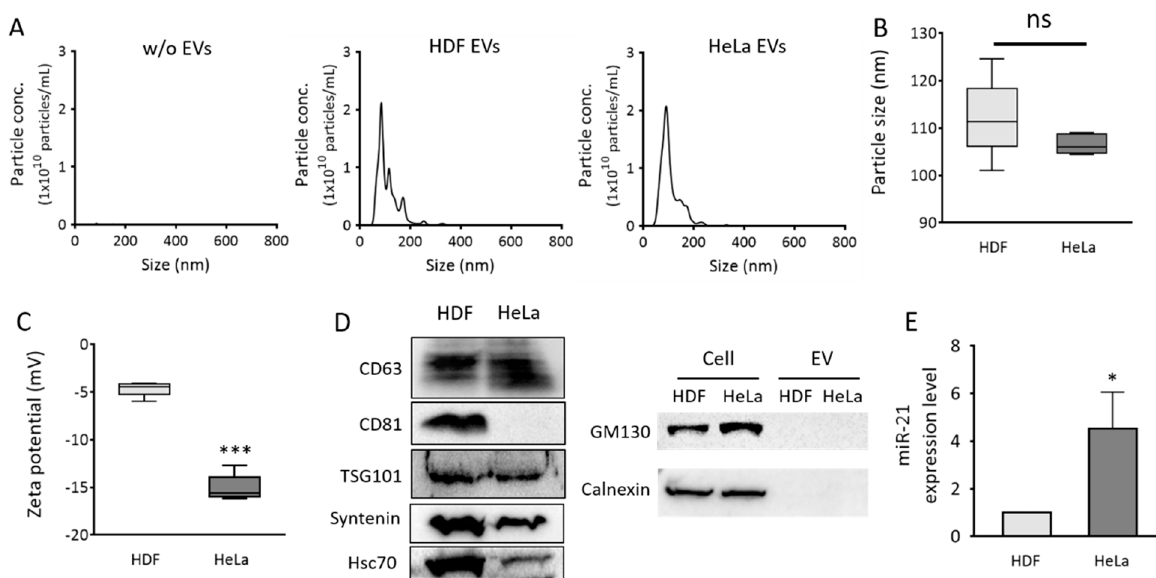
Figure 2. Size distribution, zeta potentials, protein markers, and miR-21 expression levels of EVs from normal and cancer cells. Normal (HDF) and cancer (HeLa) cell-derived EVs were purified using the ExoQuick-TC™ precipitation solution. ( A ) Size distributions of particles isolated from HDF (middle) and HeLa (right) cells were analyzed using nanoparticle tracking analysis (NTA). PBS solution without EVs was measured as control ( B ) Average sizes of particles. ( C ) Zeta potentials of normal and cancer EVs. ( D ) Western blot analysis of EV protein markers, CD63, CD81, TSG101, Syntenin, and Hsc70, and non-EV protein markers, GM130 and calnexin; 20 μ g EV proteins were loaded to each lane for detection. ( E ) Real-time PCR analysis was performed to quantify relative EV miR-21 levels in normal and cancer EVs. The miR-21 levels were normalized to those of U6 snRNA. All values are expressed as mean ± SD ( * p < 0.05, *** p < 0.001; ns: Not significant; n = 3).